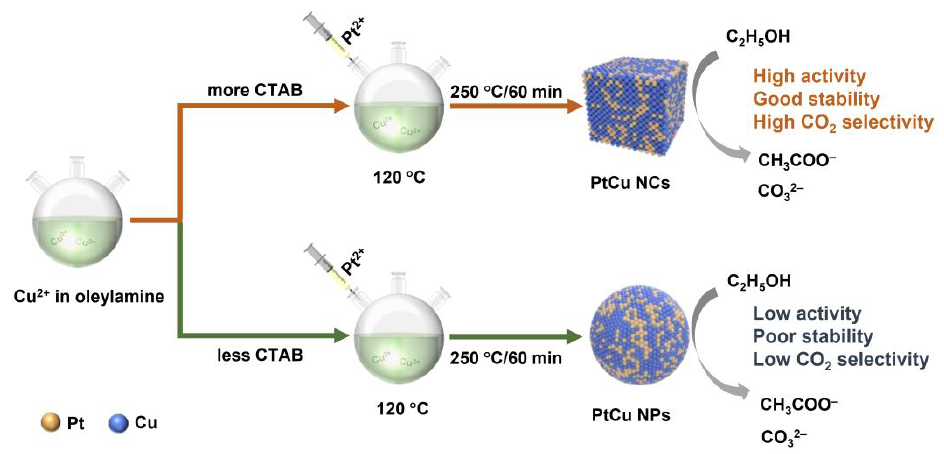
Figure 1. Scheme of the synthesis process and the EOR performance of PtCu NCs/CB and PtCu NPs/CB. The Pt atoms are shown in yellow and the Cu atoms are shown in blue.